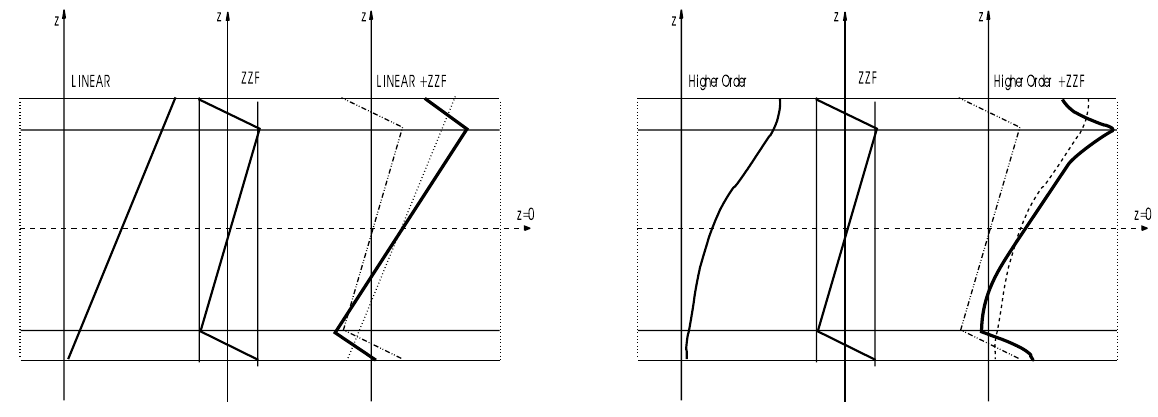
Fig. 3. Effect of adding the Zig-Zag function: linear case (left) and higher order case